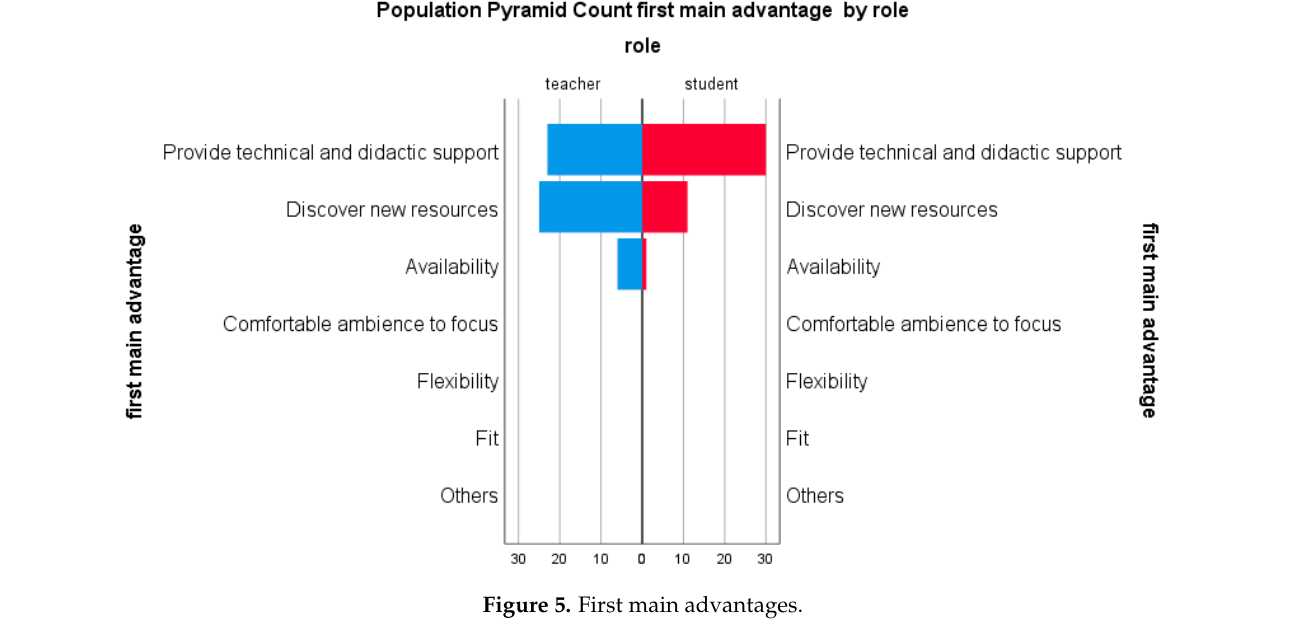
Figure 5. First main advantages. Table 5. Results of Chi-square test for variables role and first main